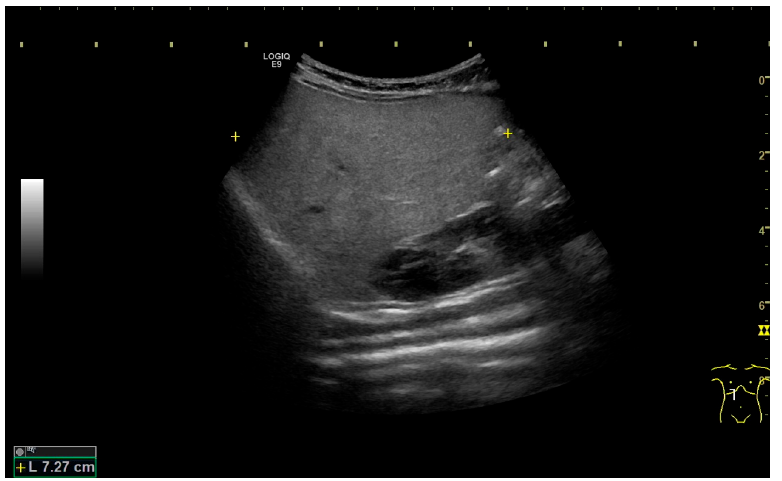
Figure 4. Abdominal sonography showed increasing homogeneous echogenicity of the liver, which is compatible with fatty liver. is compatible with fatty